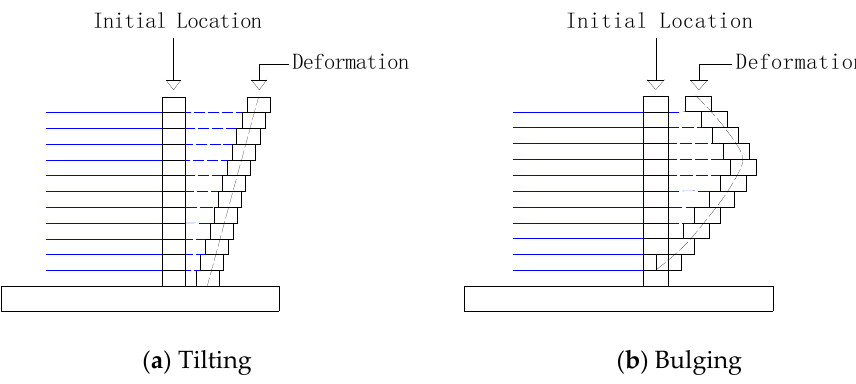
Figure 3. Horizontal deformation mode of the reinforced soil retaining wall.